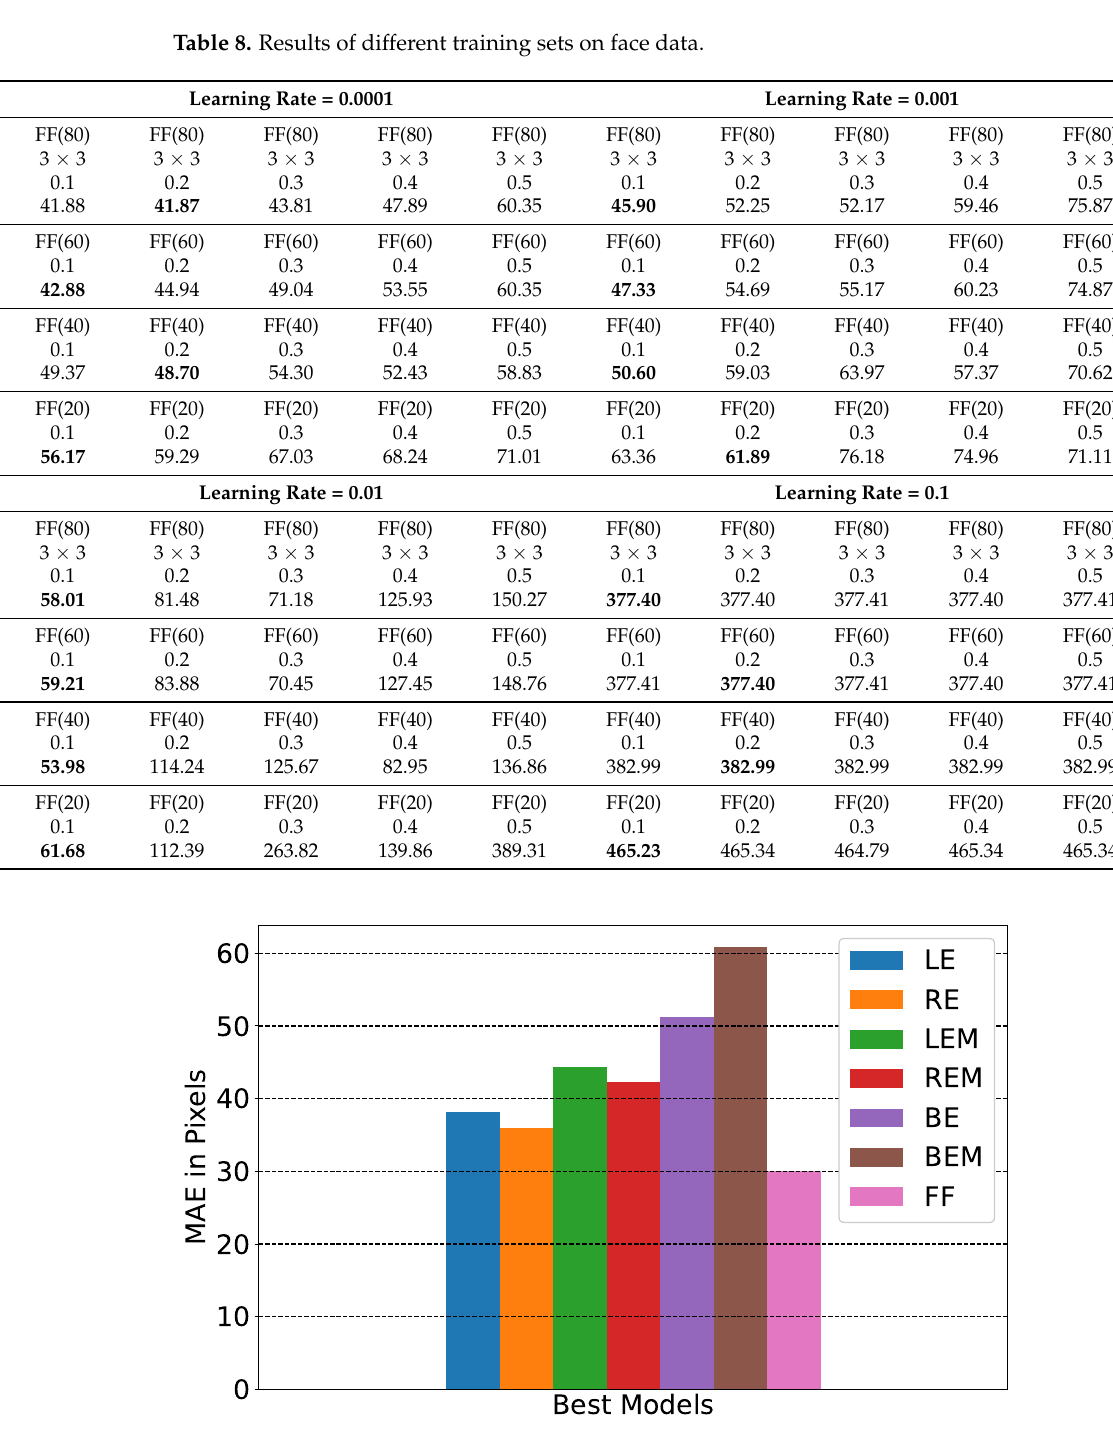
Figure 4. MAE in pixels for best